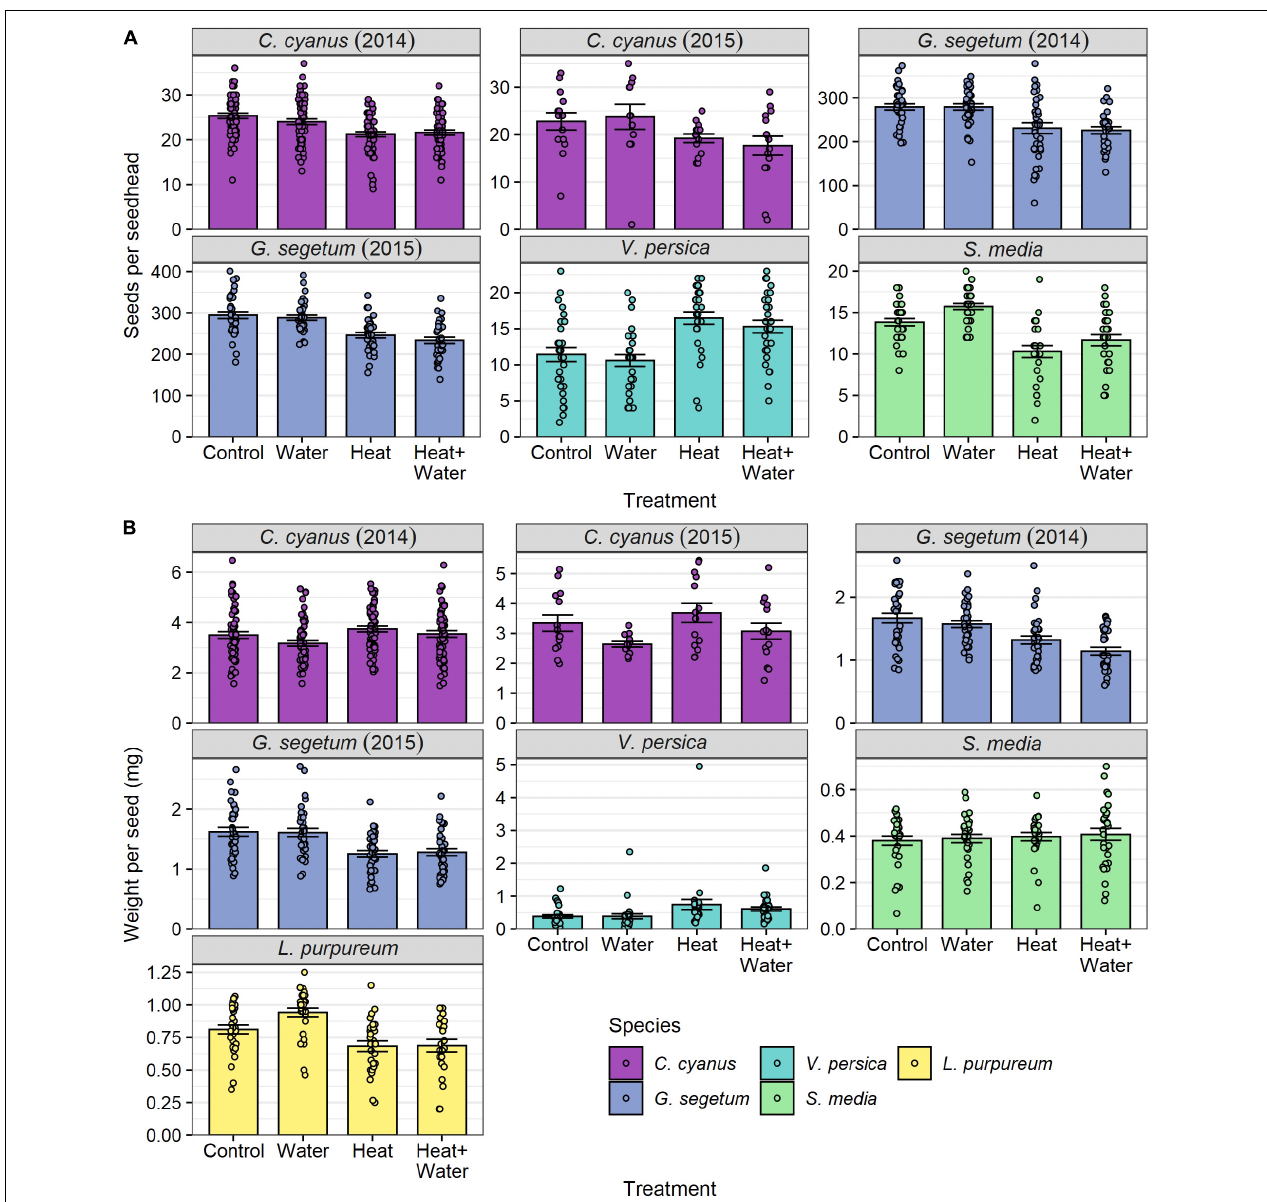
FIGURE 4 | Flowering-plant species responses to treatment for: (A) number of seeds per seed head, (B) mean seed weight per seed head (mg) (raw values). Bars and error-bars represent mean ± s.e. Points show the individual samples. For C. cyanus in 2015, L. purpureum , V. persica , and S. media sampling was restricted by the availability of ripe seed heads, leading to small differences in sample sizes between treatments and a smaller overall sample size for C. cyanus in 2015 (see Supplementary Table 6